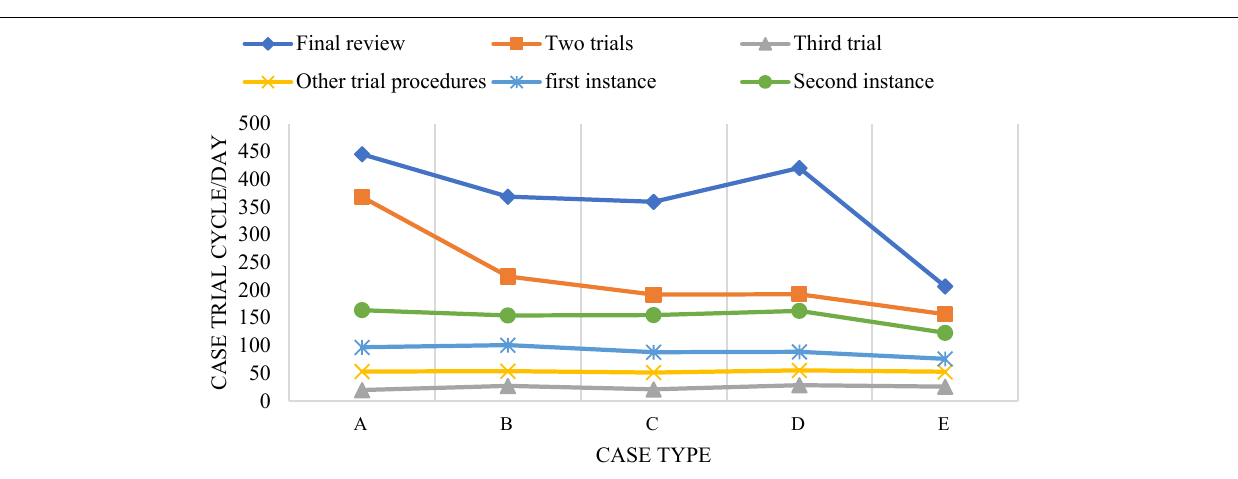
FIGURE 15 | The trial cycle of different types of cases with the help of artificial intelligence based on deep learning technology. (A: Traffic accident infringement; B: copyright infringement; C: trademark infringement; D: copyright protection; E: theft infringement).